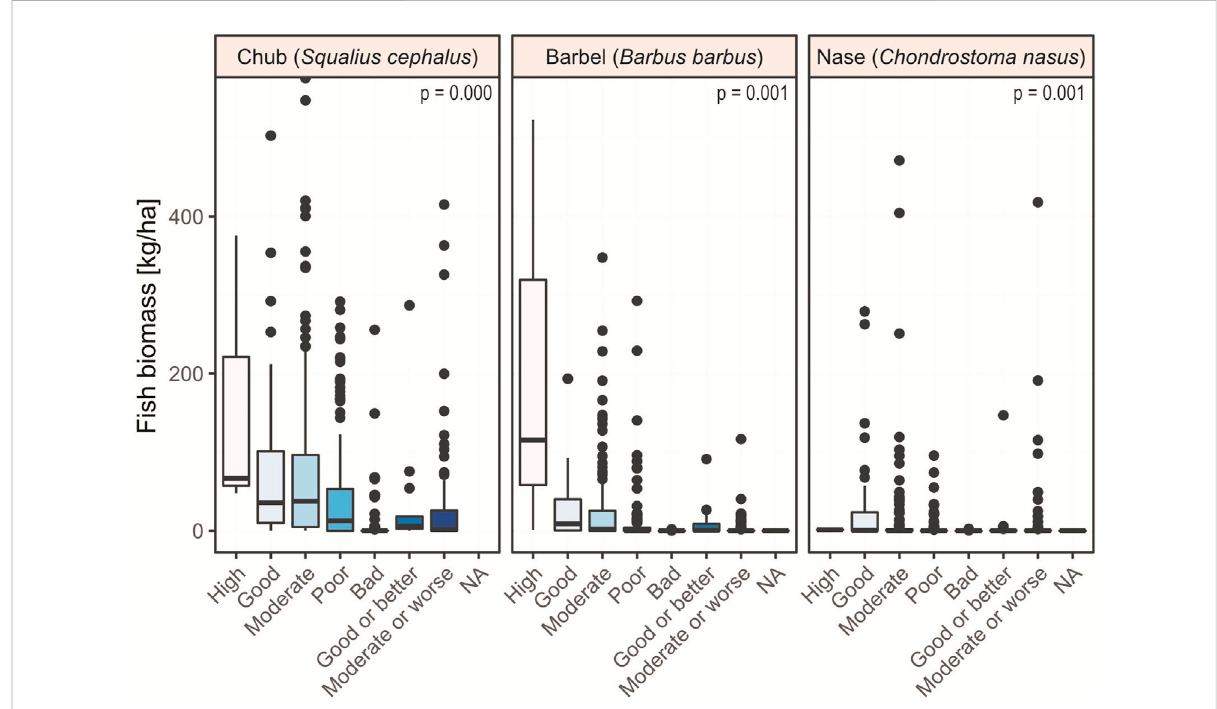
FIGURE 6 Biomass of the three target species with sites separated by the ecological status assessment according to the EU Water Framework Directive (2000/60/EC). Outliers and data points > 550 kg/ha have been graphically cut off for better readability (chub: n = 7, max = 1,107 kg/ha; barbel: n =